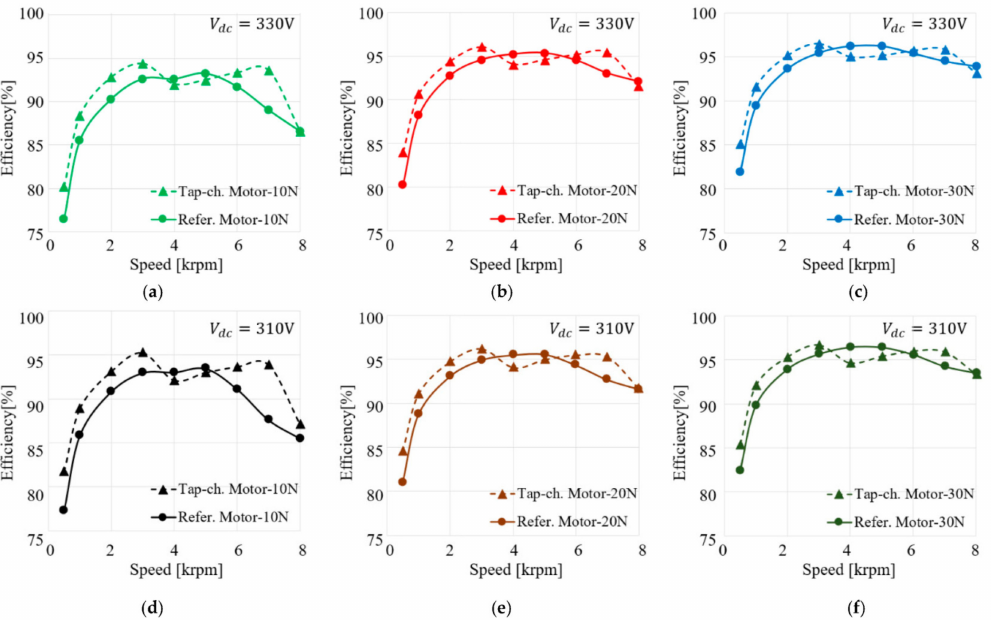
Figure 12. Experimental results. Comparison of the efficiency of the tap-change motor and reference motor at different speeds and torque conditions: ( a ) 10 Nm, ( b ) 20 Nm, ( c ) 30 Nm with V dc = 330 V, and ( d ) 10 Nm, ( e ) 20 Nm, ( f ) 30 Nm with V dc = 310 V.